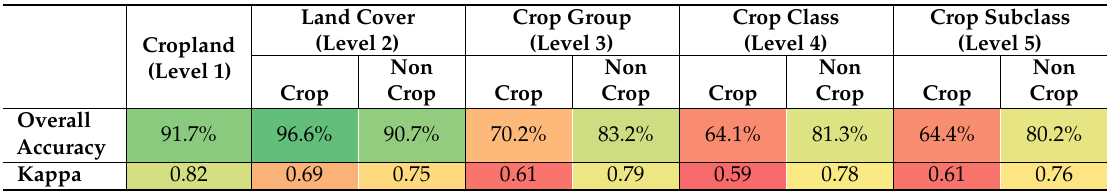
Figure 4. Optimal number of variables needed to reach the best level of overall accuracy for each domain (crop/non-crop) and each nomenclature level via a hierarchical approach.